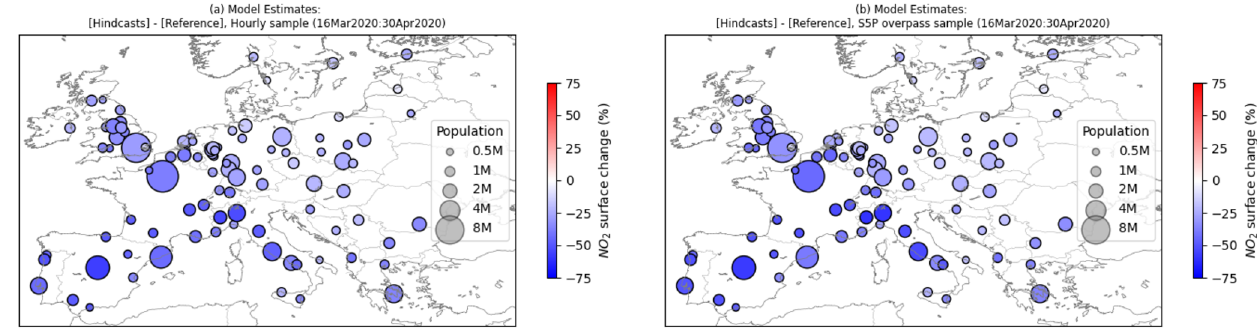
Figure 8. Air quality modelling estimates of surface NO 2 changes (%; relative to the BAU predictions) during the lockdown period in urban areas with at least 0.5 million inhabitants. Panel (a) shows the estimates using full hourly datasets, and panel (b) shows the estimates using the S5P-sampled overpass time dataset. The diameter of the circles is proportional to the population in each urban